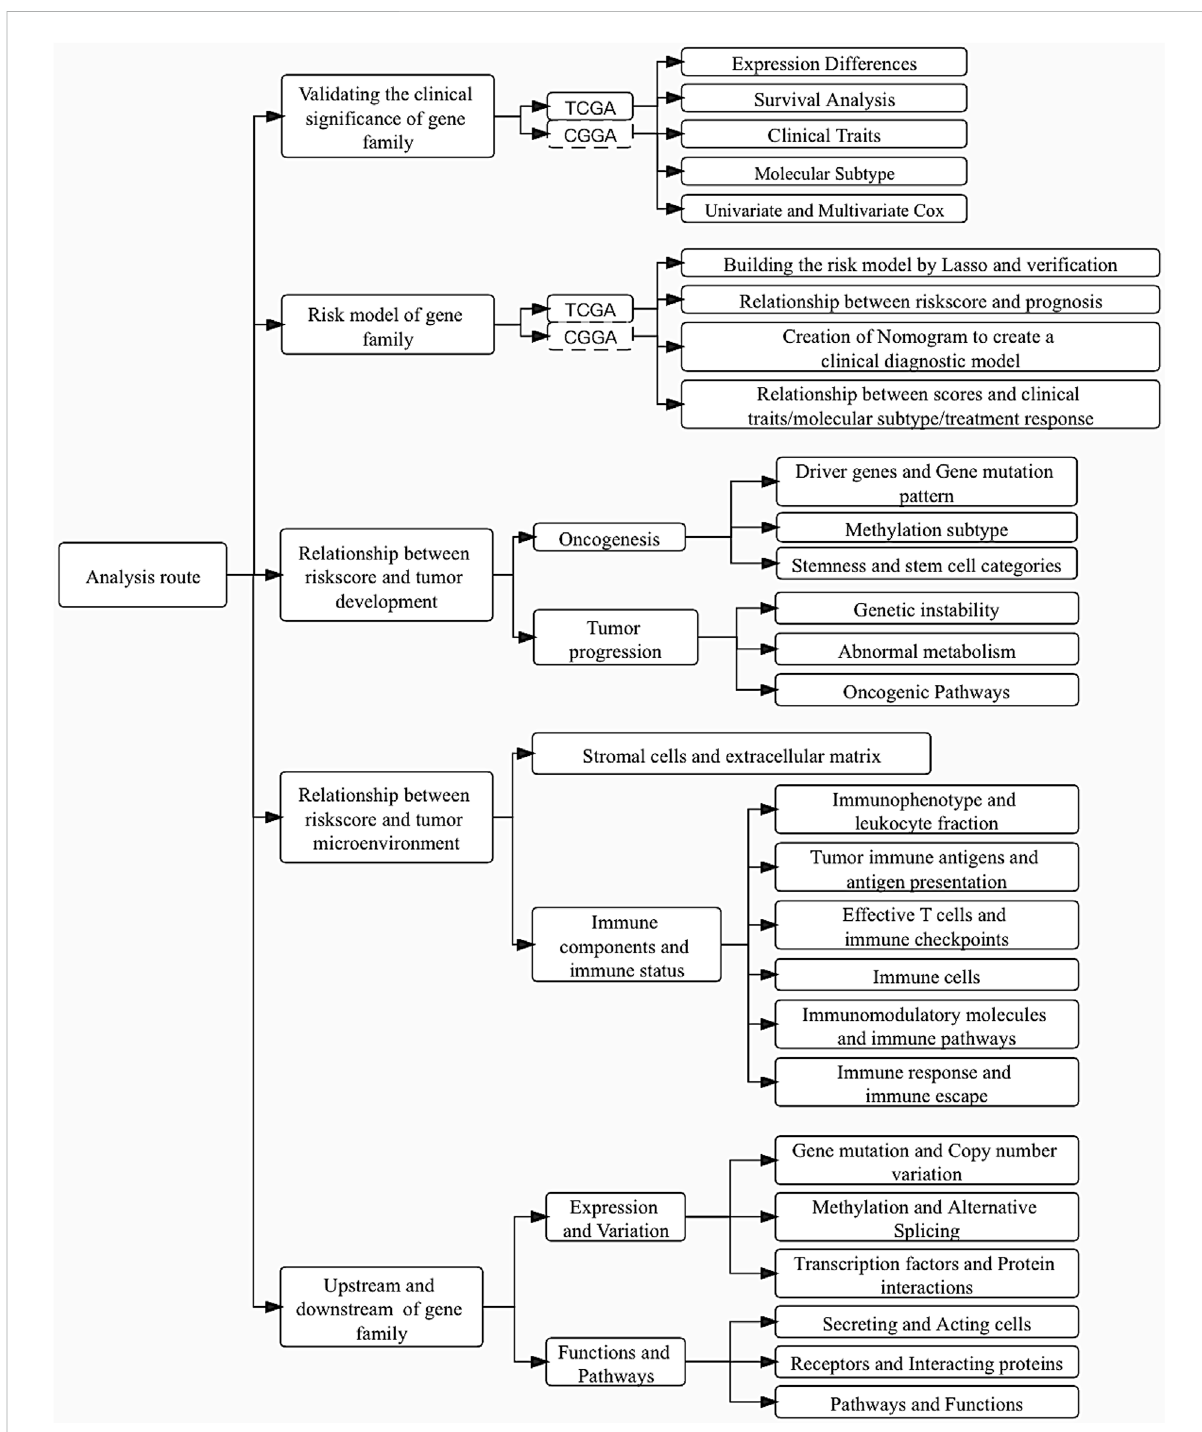
FIGURE 1 Article fl